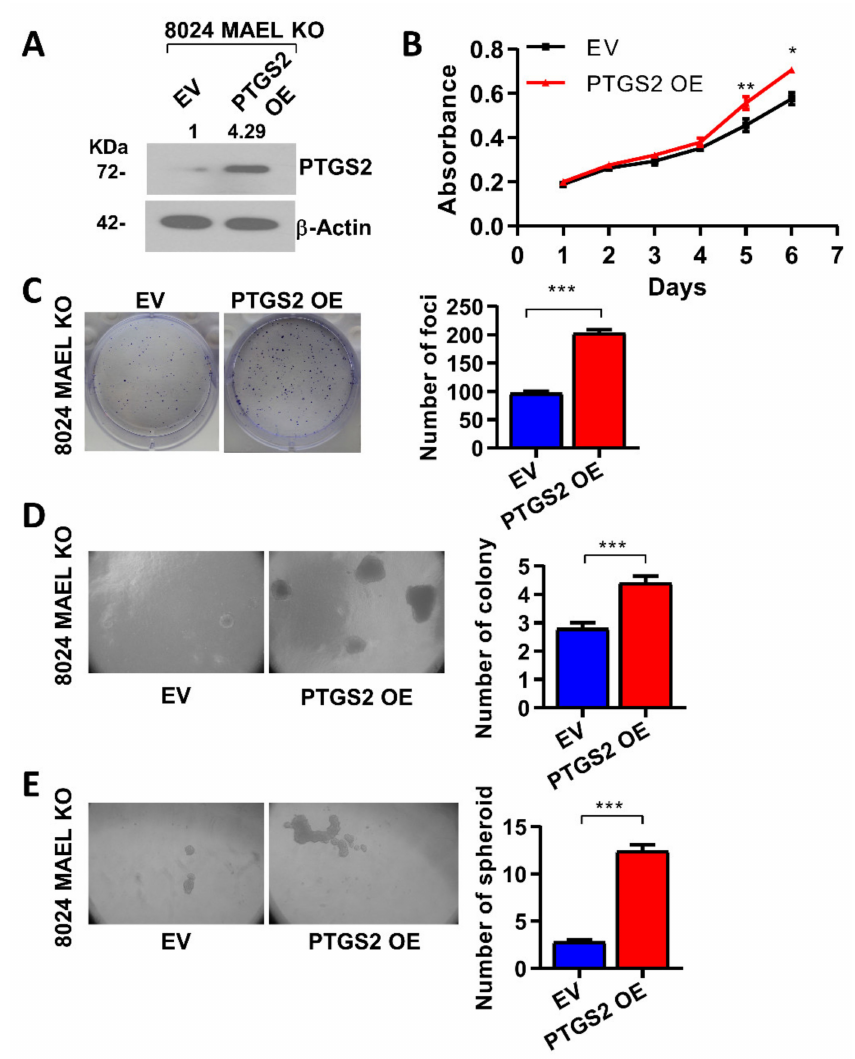
Figure 6. PTGS2 restores cancer properties in MAEL-deletion cells. ( A ) Western blots showed ectopic expression of PTGS2 in MAEL knockout 8024 cells. β -Actin served as internal control. Full Western Blot can be found in Figure S8. ( B ) Growth curve of PTGS2 overexpression cells determined by XTT assay. Representative images and quantitation of ( C ) foci formation, colony formation in soft agar ( D ), and ( E ) spheroid formation in MAEL knockout 8024 cells with or without PTGS2 overexpression. The values indicate the mean ± SD of three independent experiments. * p < 0.05; ** p < 0.01; *** p <